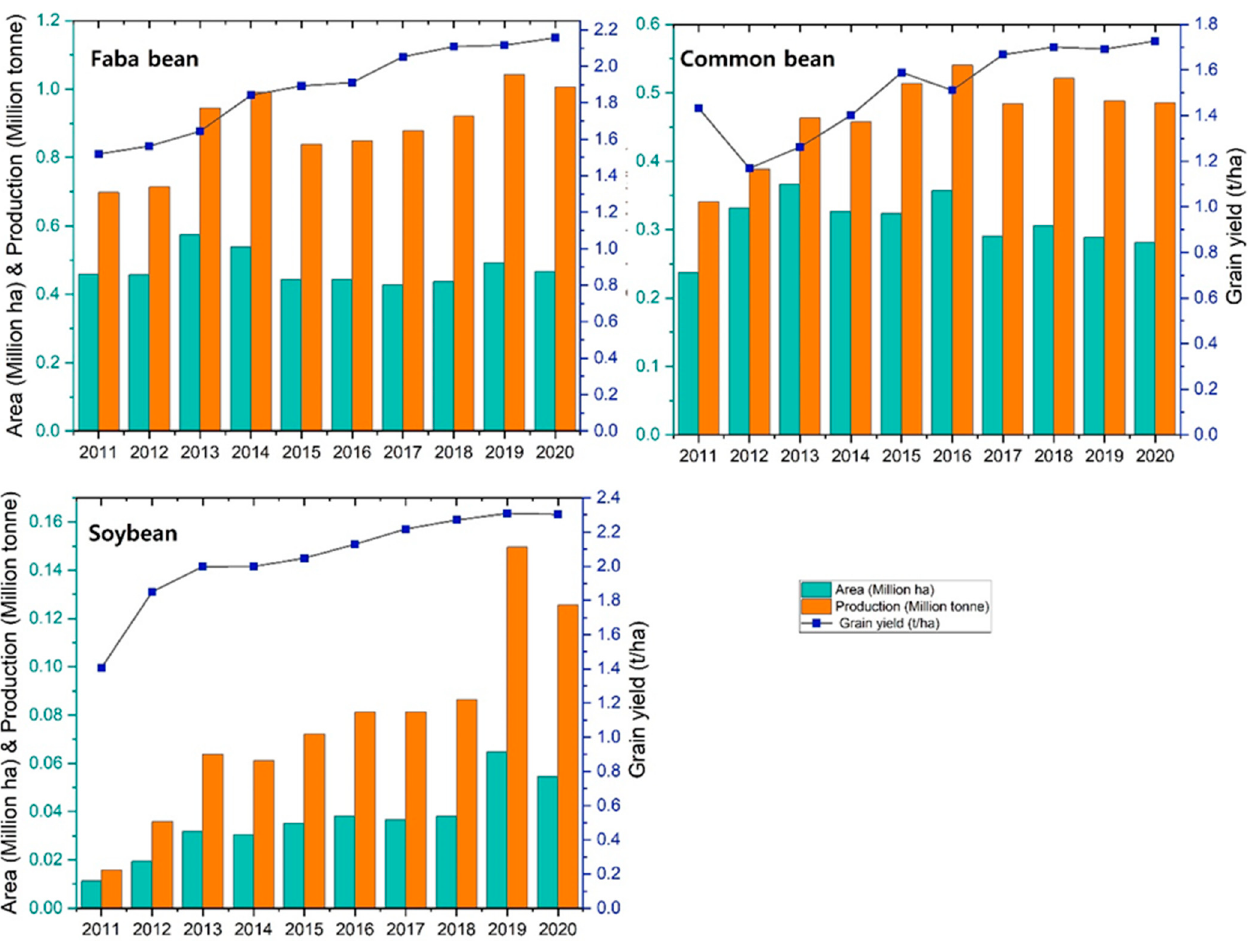
Figure 2. Changes in area, production, and yield of grain legume crops between 2011 and 2020.